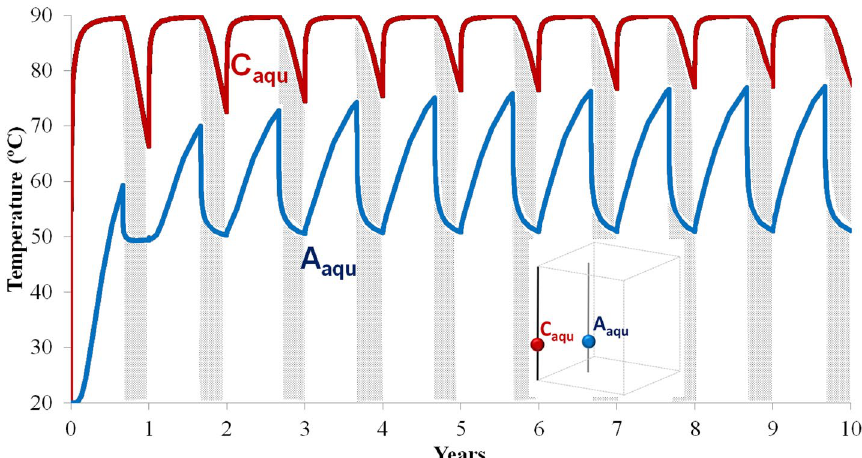
Fig. 9 Evolution of temperature during 10 years of operation on the aquifer near central well (C aqu ) and near the auxiliary well